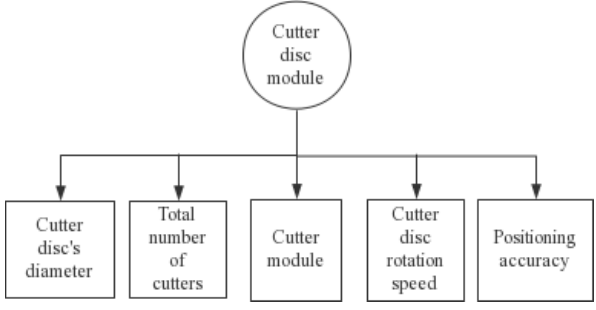
Figure 7. Cutter disc module